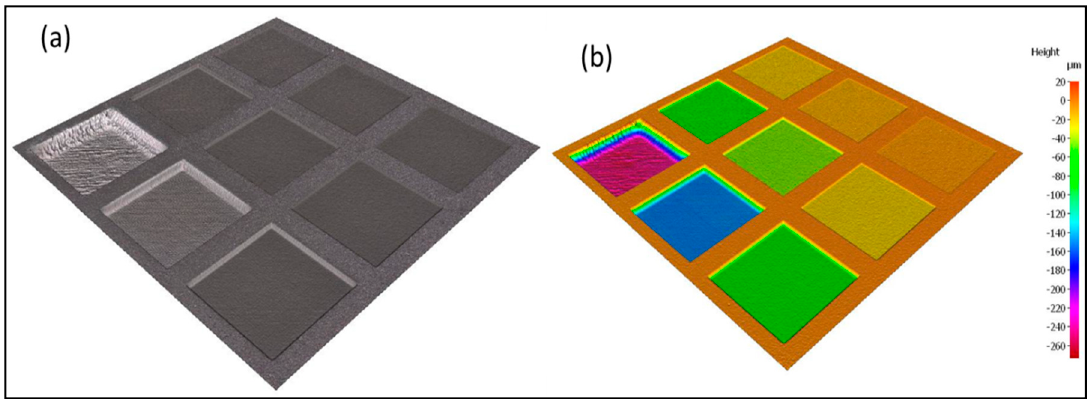
Figure 5. ( a ) 3D view of the nine machined 2 mm × 2 mm squares during the laser parameter optimisation trials; ( b ) pseudo-colour representation of ( a ).